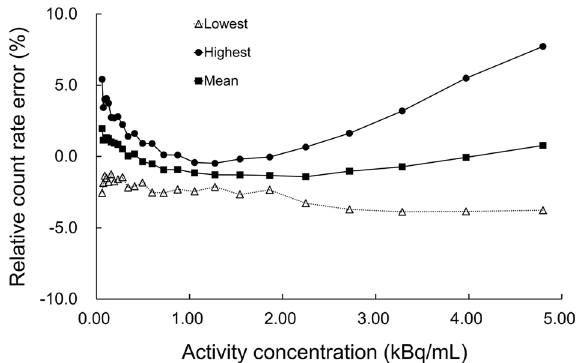
Fig. 4 The highest, lowest, and mean values of the bias in relation to activity